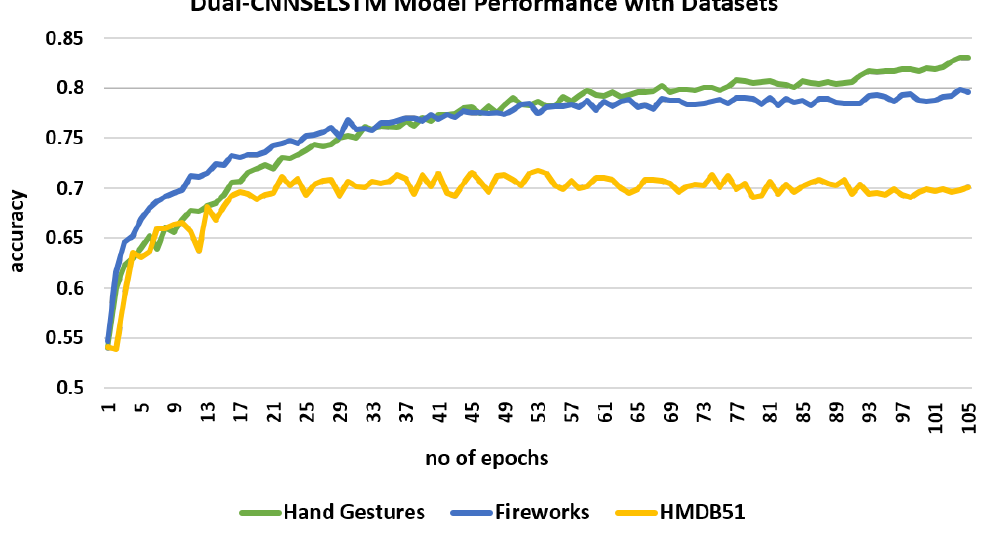
Figure 7. Training accuracies of the Dual-CNNSELSTM model with the hand gestures, fireworks, and HMDB51 datasets.